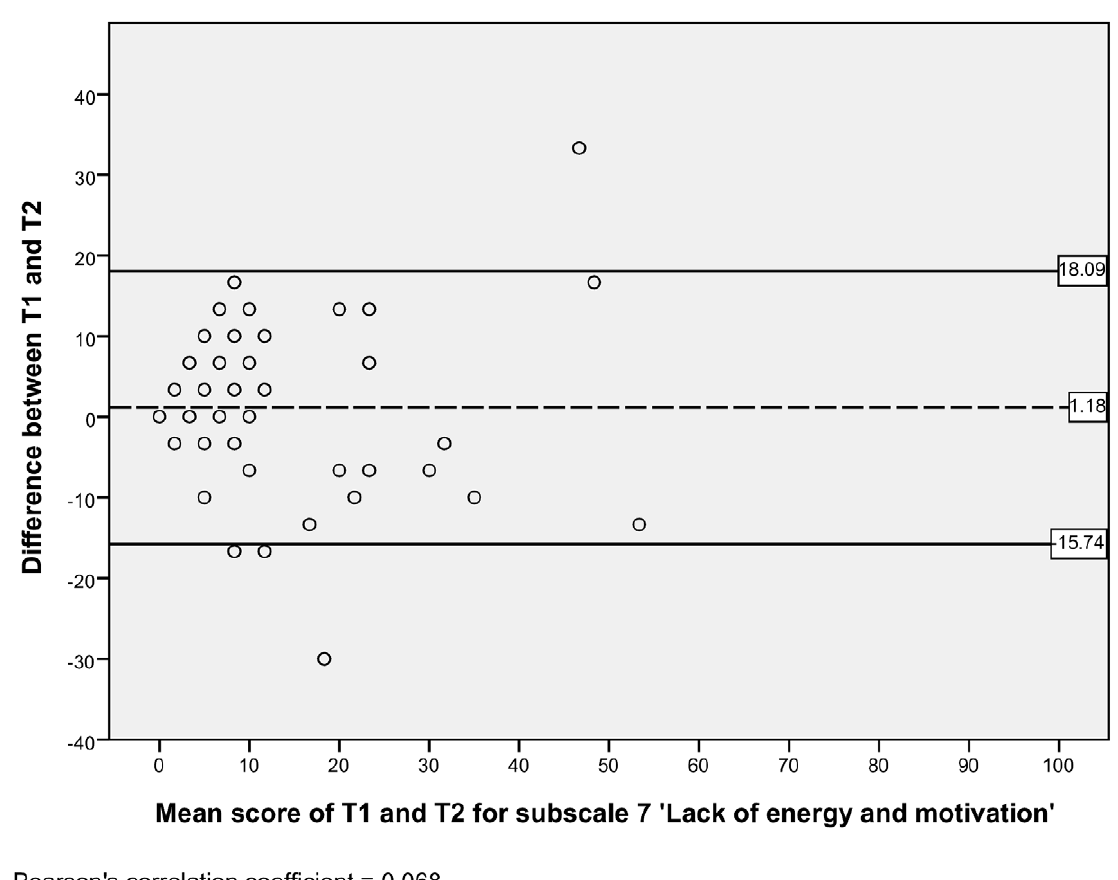
Figure 7. Bland and Altman plot for subscale 7 ‘Lack of energy and motivation’.